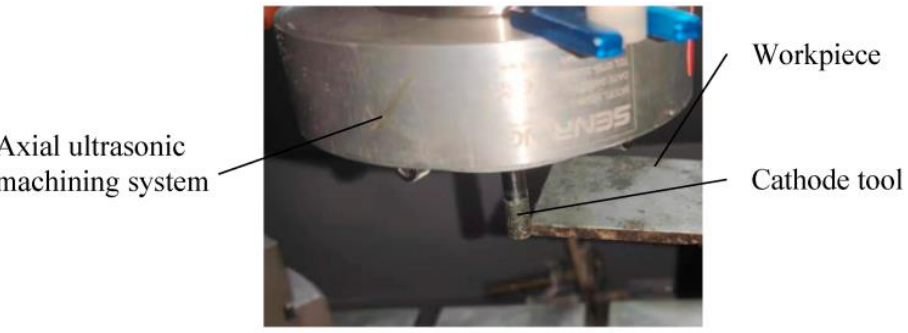
Figure 4. The machining area.